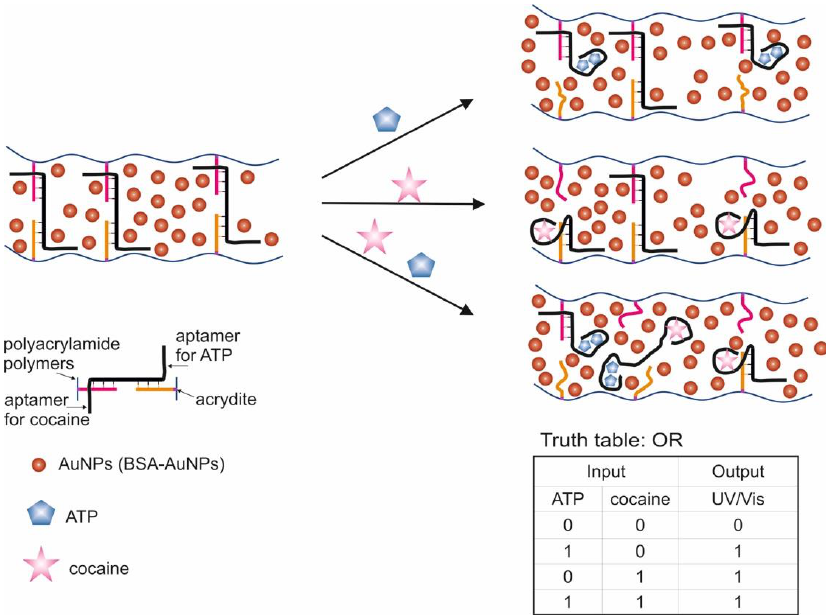
Figure 8. The OR logic gate. ATP = adenosine triphosphate. Adapted from Reference [106] by permission of The Royal Society of Chemistry.